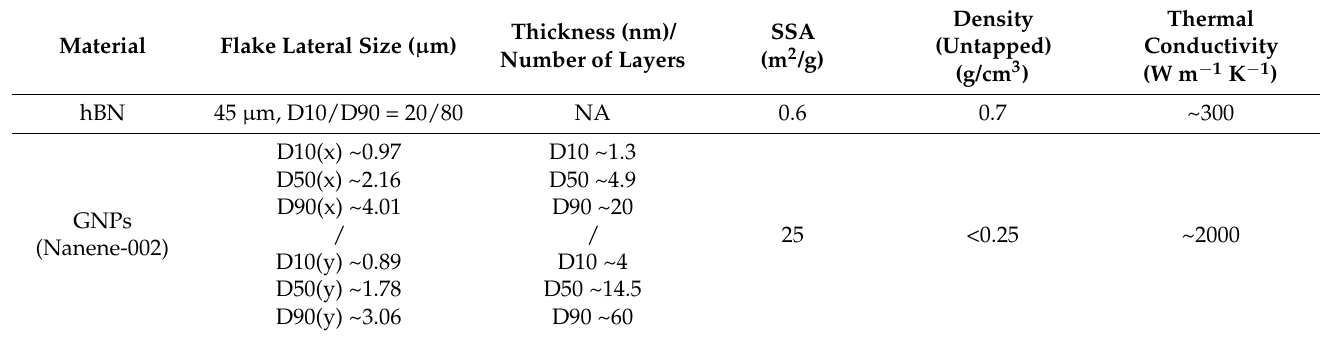
Table 1. Lateral size, thickness, specific surface area (SSA), and apparent density of the fillers used.